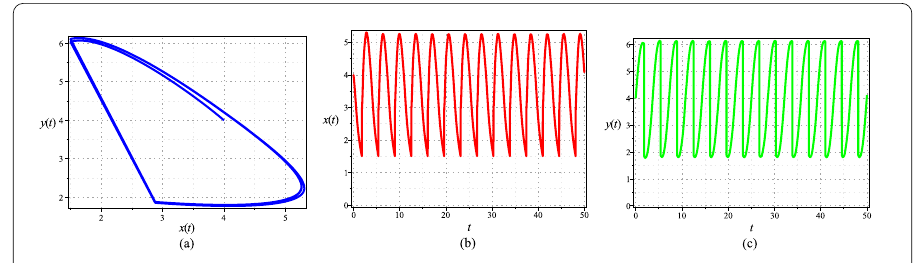
< (1 – p h ) h + τ h < x E . (a) Phase portrait of prey 1 2